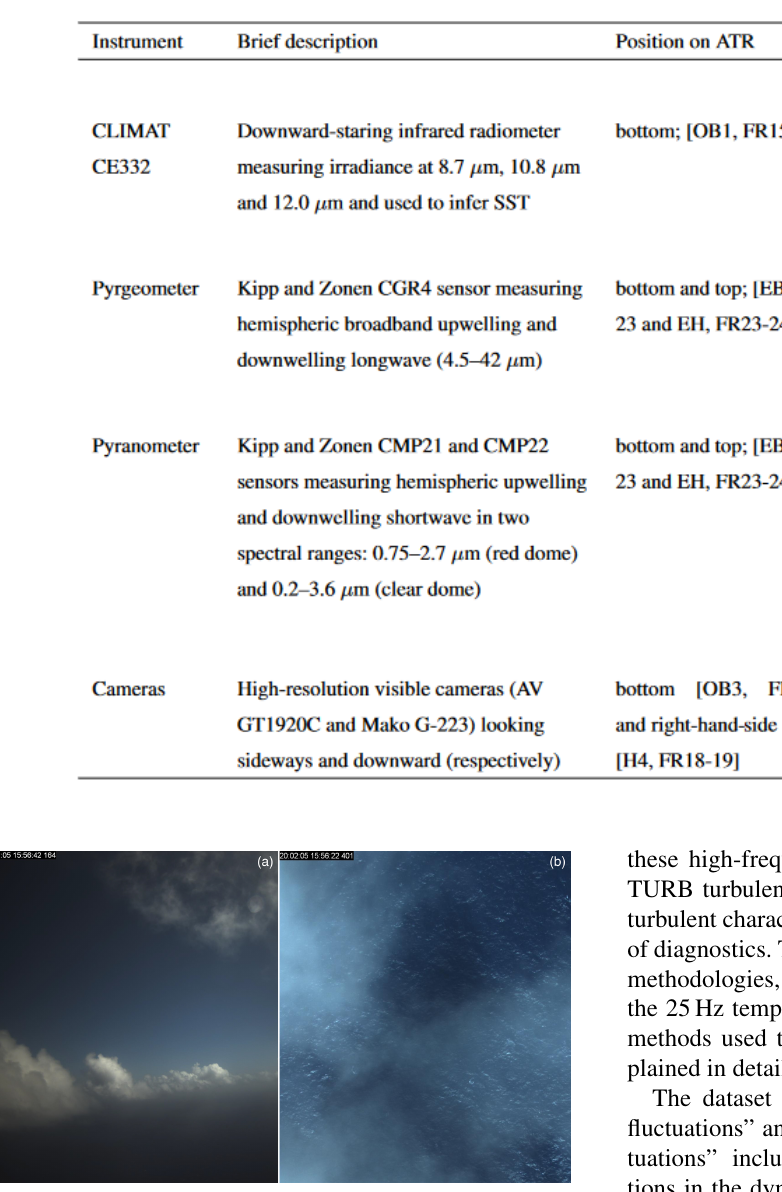
Figure 8. (a) Example of a cumulus scene captured by the vis- ible camera through the aircraft window on 5 February 2020 at 15:56UTC. (b) Image acquired a few minutes earlier by the camera looking down towards the